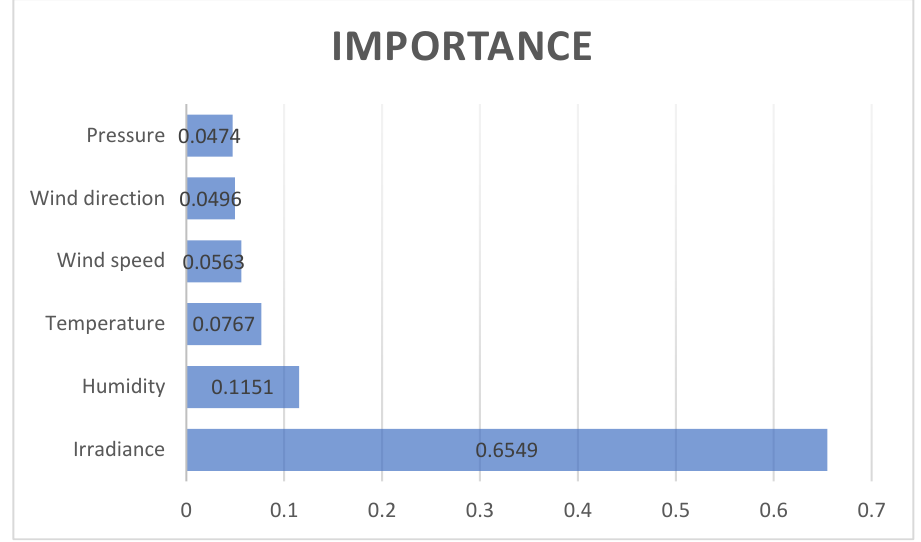
Figure 9. Feature importance.